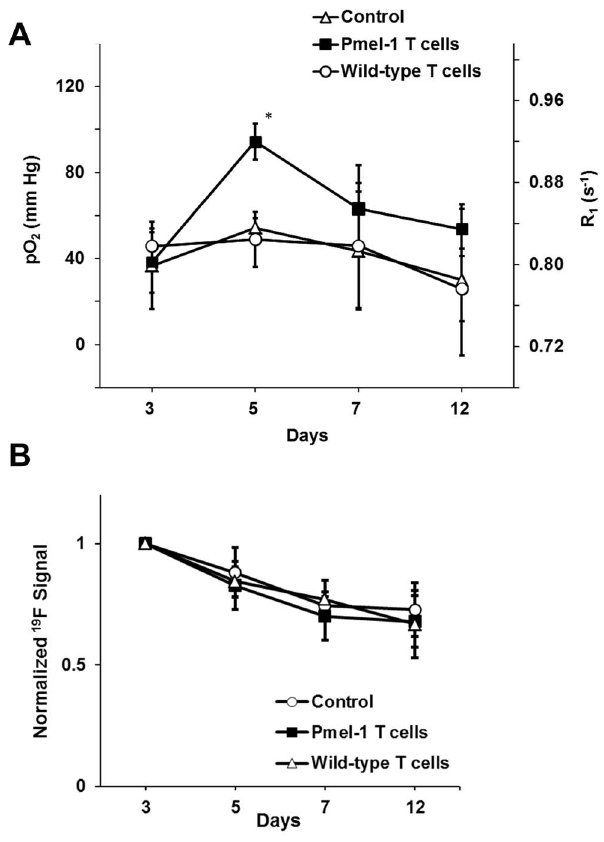
Figure 3. Invivo longitudinal pO 2 changes of CNS GL261 tumor. Panel ( A ) shows the pO 2 (left axis) and R 1 (right axis) values. Panel ( B ) displays the total normalized 19 F signal of the tumor over time. On day 3, Pmel-1 antigen-specific CD8 + T cells or wild-type T cells were injected into the corresponding groups, and the control group received no cells. Here, (*) denotes p , 0.05 comparing Pmel-1 group with wild-type T cell and no-cell groups.